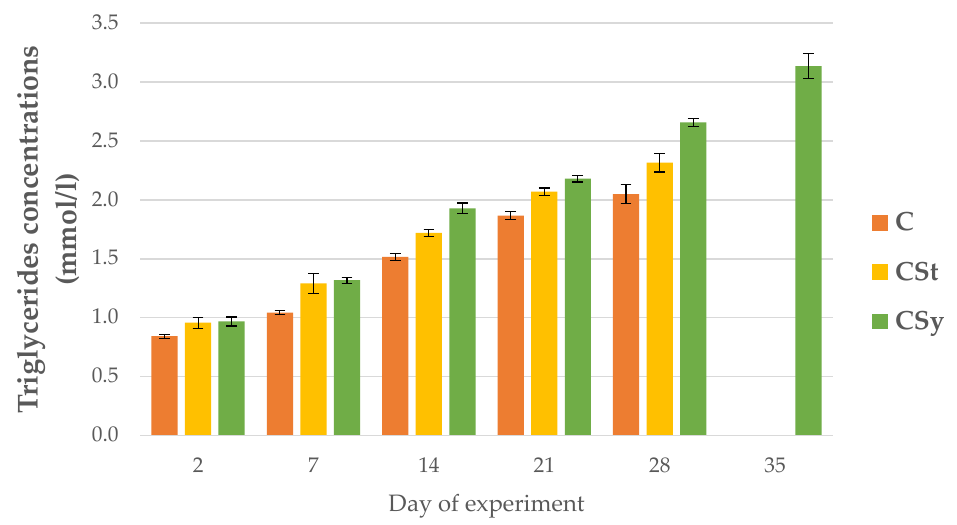
Figure 12. Triglyceride concentrations in the 2, 7, 14, 21, 28, 35-day-old workers’ hemolymph after two methods of supplementation with hemp extract: C-control (pure sugar syrup), CSy-hemp extract in syrup, CSt-hemp extract on strips. Two-Way ANOVA: supplementation method: F (2, 156) = 12.927, p = 0.00001, se ± 0.085425–0.077199; days of supplementation: F (4, 143) = 3683.5, p = 0.0000, se ± 0.009509–0.016471; supplementation method × days of supplementation F (8, 143) = 33.426, p = 0.0000, se ± 0.016471–0.017362.